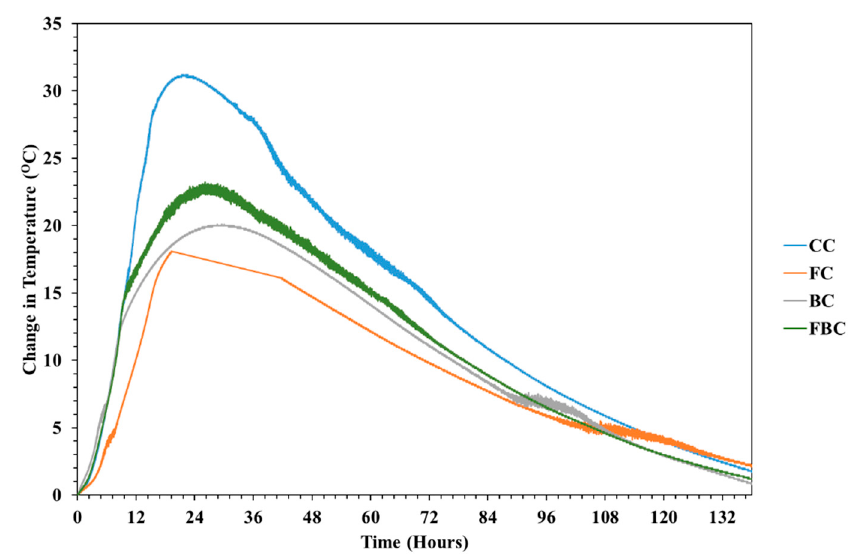
Figure 8. Temperature variations with respect to time on mass concrete specimens.